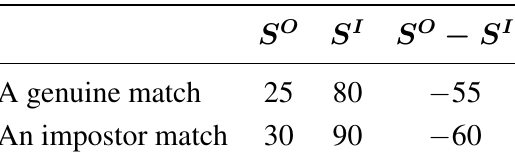
( S O and S I are all from zero to 100